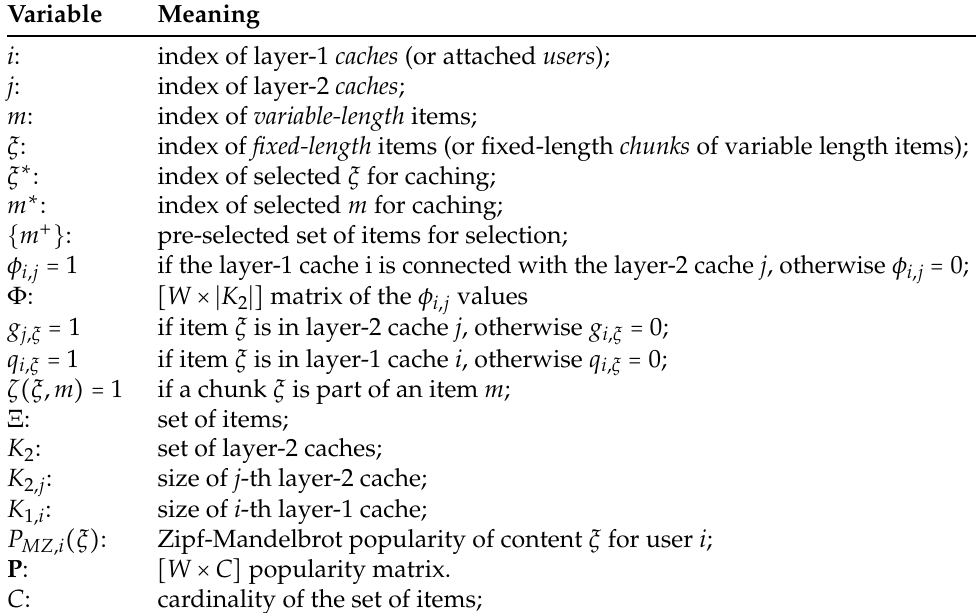
Table 1. Principal